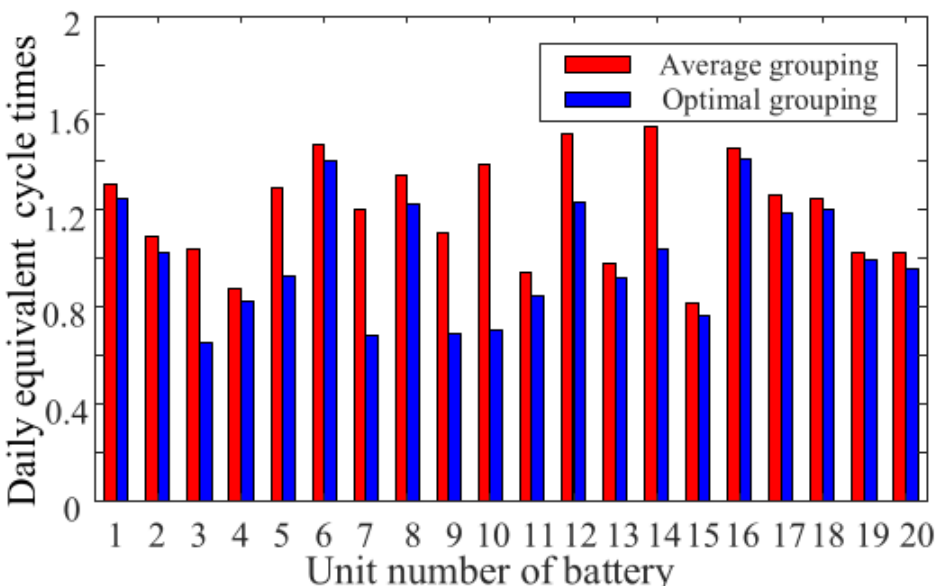
Figure 9. Daily equivalent cycle times of each energy storage